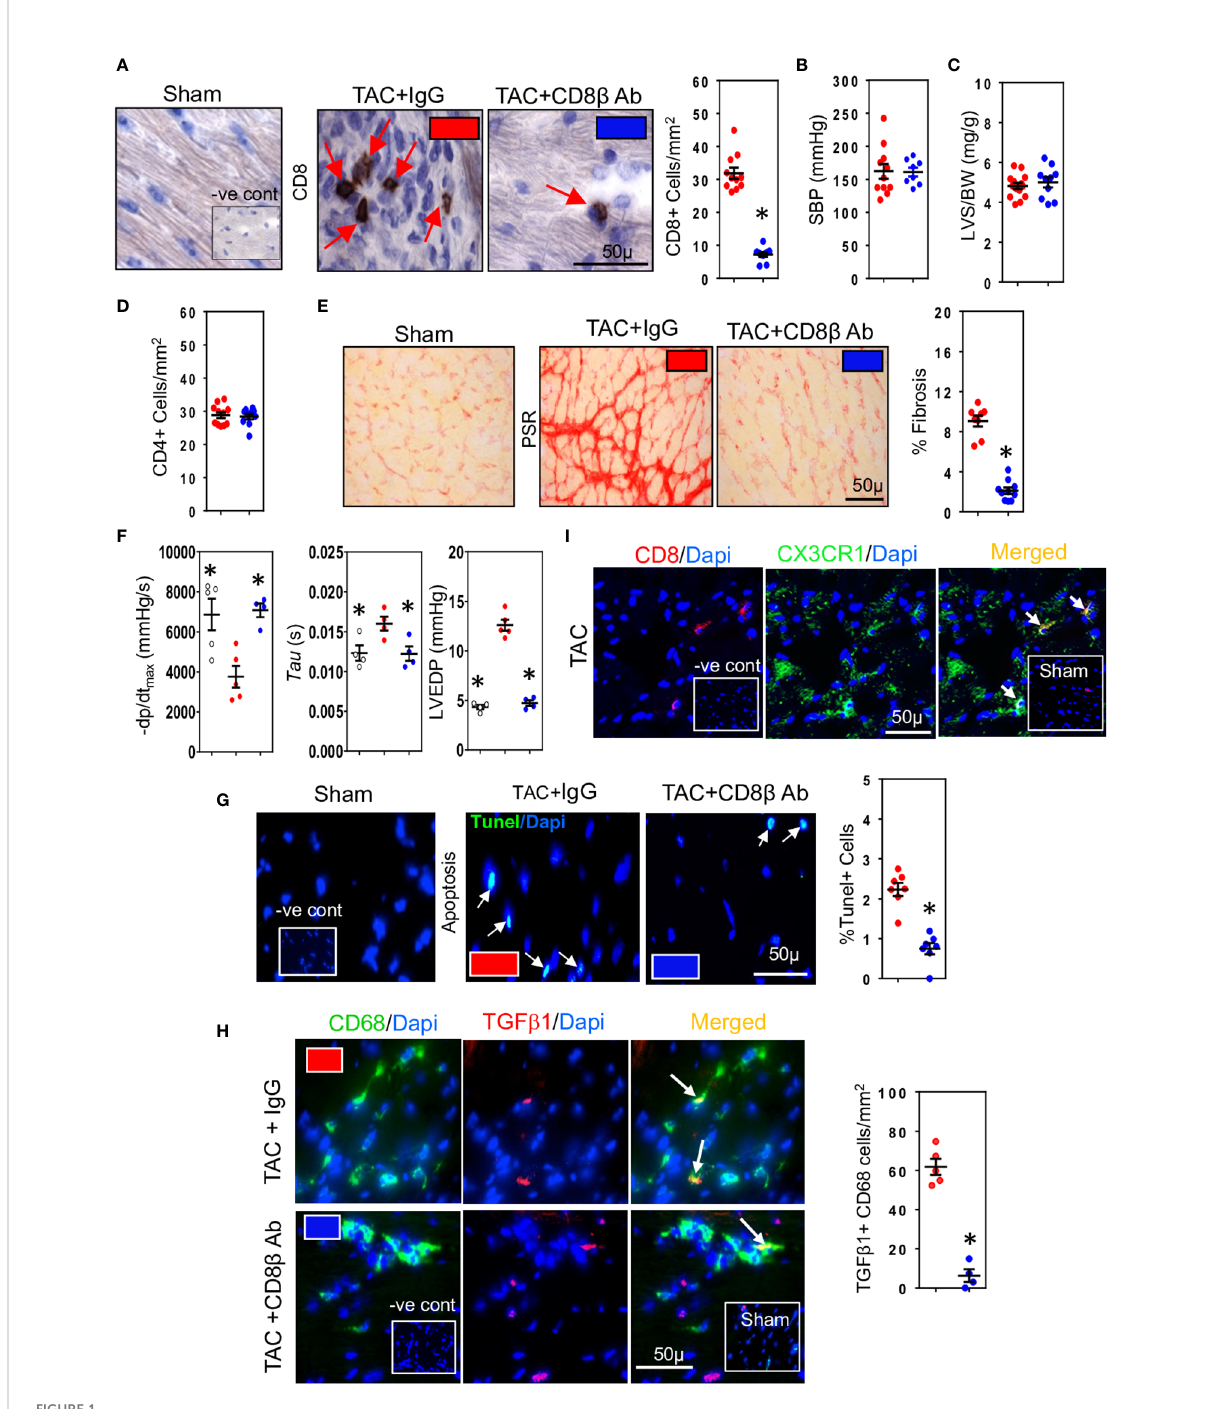
FIGURE 1 CD8+ T cells promote hypertension-induced cardiac fi brosis. (A) Representative photomicrographs of CD8+ T cells within the left ventricle (LV) of hypertensive TAC mice and their depletion using anti-CD8 b antibodies. (B) Systolic aortic blood pressures (SBP) recorded in aortas by micromanometry and (C) LV hypertrophy measured as wall plus septum/body weight (LVS/BW) ratio in TAC mice with/without CD8 ab + T cells. (D) CD4+ T cells in LV are unaffected by CD8 ab + T cell depletion. (E) Photomicrographs showing the reduction in LV fi brosis in TAC mice associated with CD8 ab + T cell depletion. (F) Effects of CD8 ab + T cell depletion on LV diastolic function (-dp/dt, Tau and LVEDP) measured by micromanometry. (G) Photomicrographs showing reductions in TUNEL+ (apoptotic) cells in LV following CD8 ab + T cell depletion. (H) Photomicrographs depicting effects of CD8 ab + T cell depletion on CD68+ macrophages expressing TGF- b 1 in LV of TAC mice. (I) Photomicrographs showing CD8+ T cells accumulated in TAC left ventricle expressing CX3CR1. Results are means ± SEM with small circles representing data from individual mice. n=6-12/group. PSR; picrosirius red, -ve control; no primary antibody control, sham; sham-operated, scale bar represents 50µm. *P < 0.05 using two-tailed Student ’ s t-test or one-way ANOVA comparing to